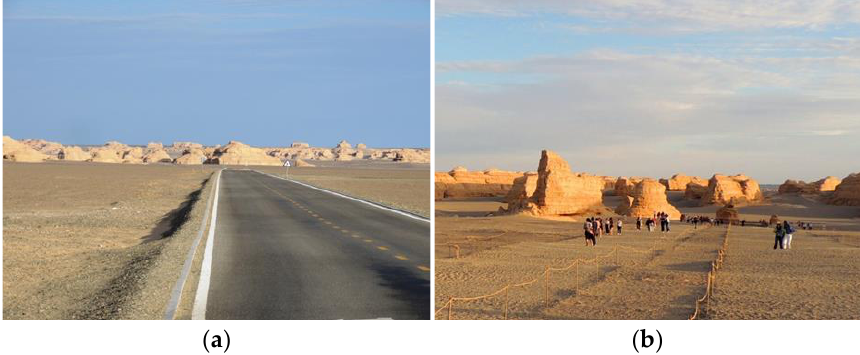
Figure 4. ( a ) The road inside the Yardang National Geopark (credit Loredana Luvidi); ( b ) the geosite of the Yardang National Geopark (credit Fabio Fratini) .